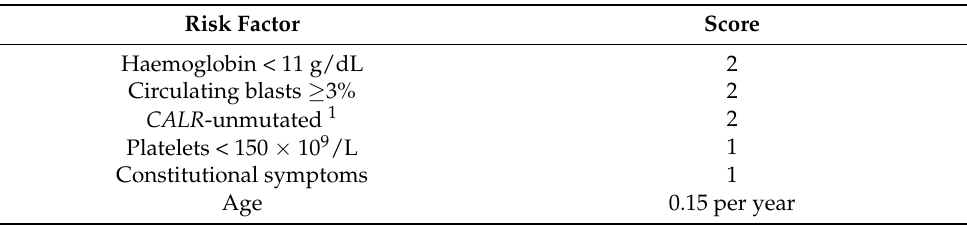
Table 4. Stratification of risk of survival in post-PV MF according to the Myelofibrosis Secondary to PV and ET Prognostic Model (MYSEC-PM) (adapted from [181]). Patients are classified into